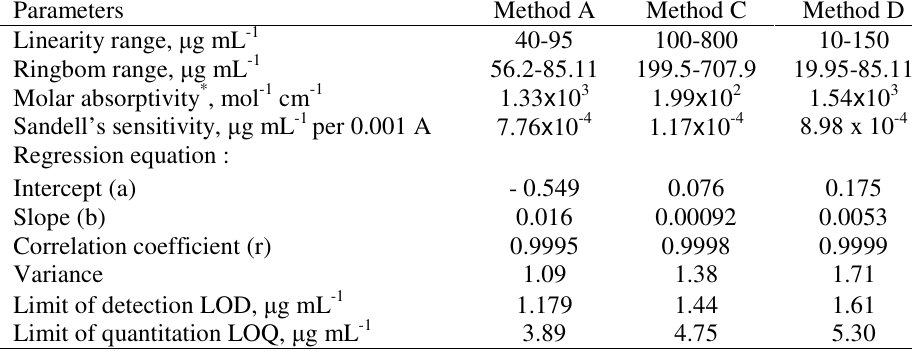
Table 1. Spectral characteristics and statistical data of the regression equations for the product formed through reactions (A, C and D) Parameters